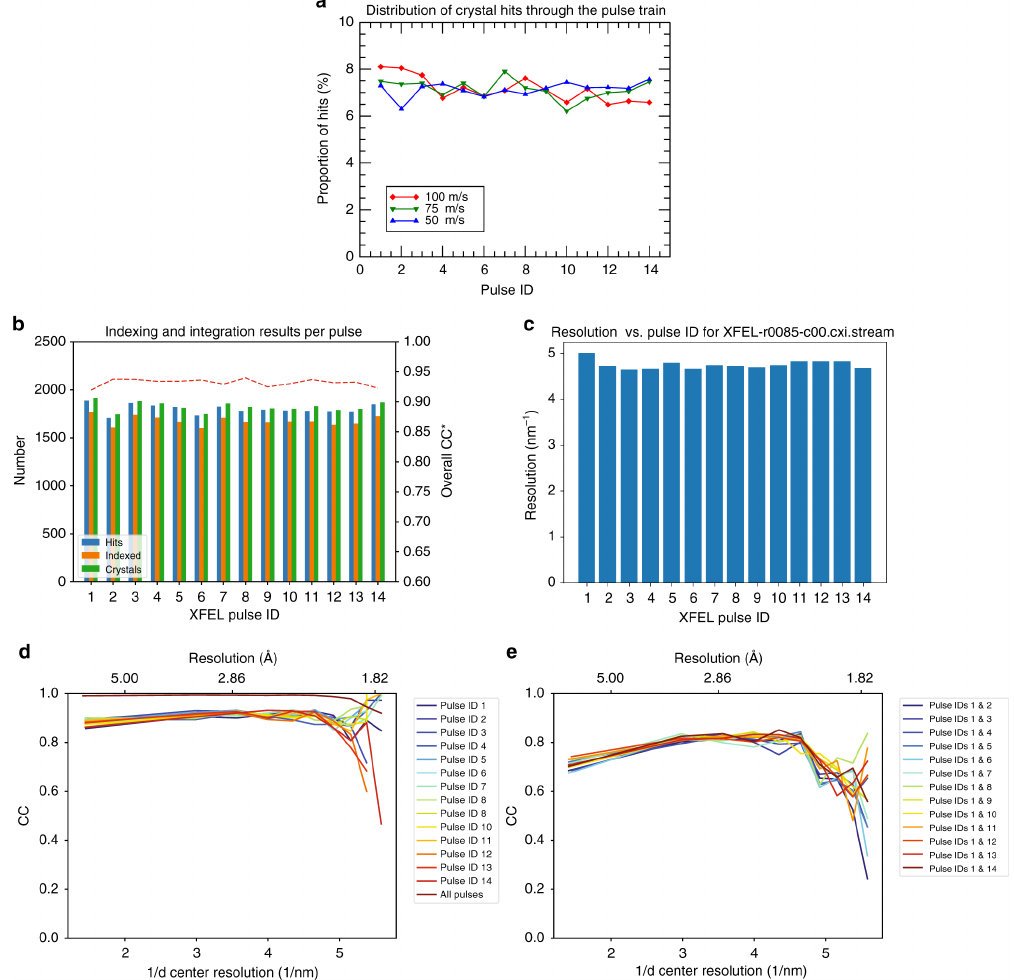
Figure 5. Graph ( a ) and histograms ( b , c ) suggest a stable sample delivery system with an approximately equal probability of a diffraction event across the pulse train. Graphs ( d , e ) show data quality metrics as a function of resolution. Figure originally published in Nat. Commun.